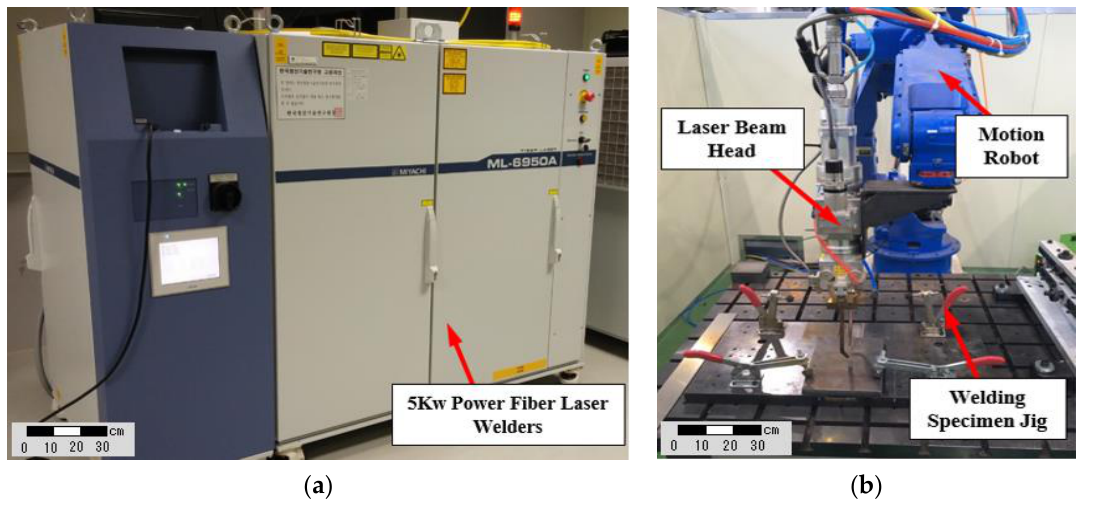
Figure 2. Fiber laser welding equipment. ( a ) 5kw fiber laser power source; ( b ) welding torch